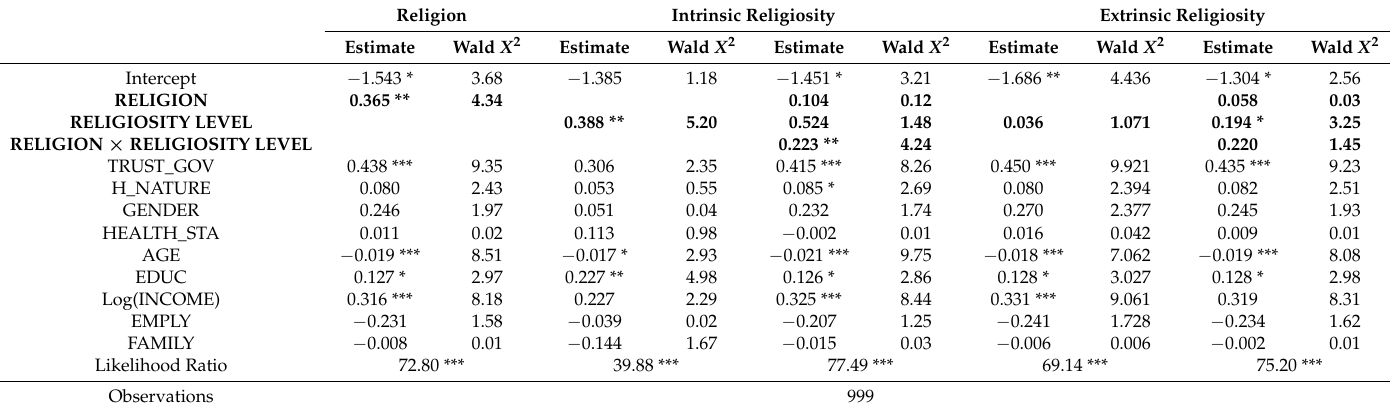
Table 5. The effect of religion and religiosity level on the willingness to donate organ.